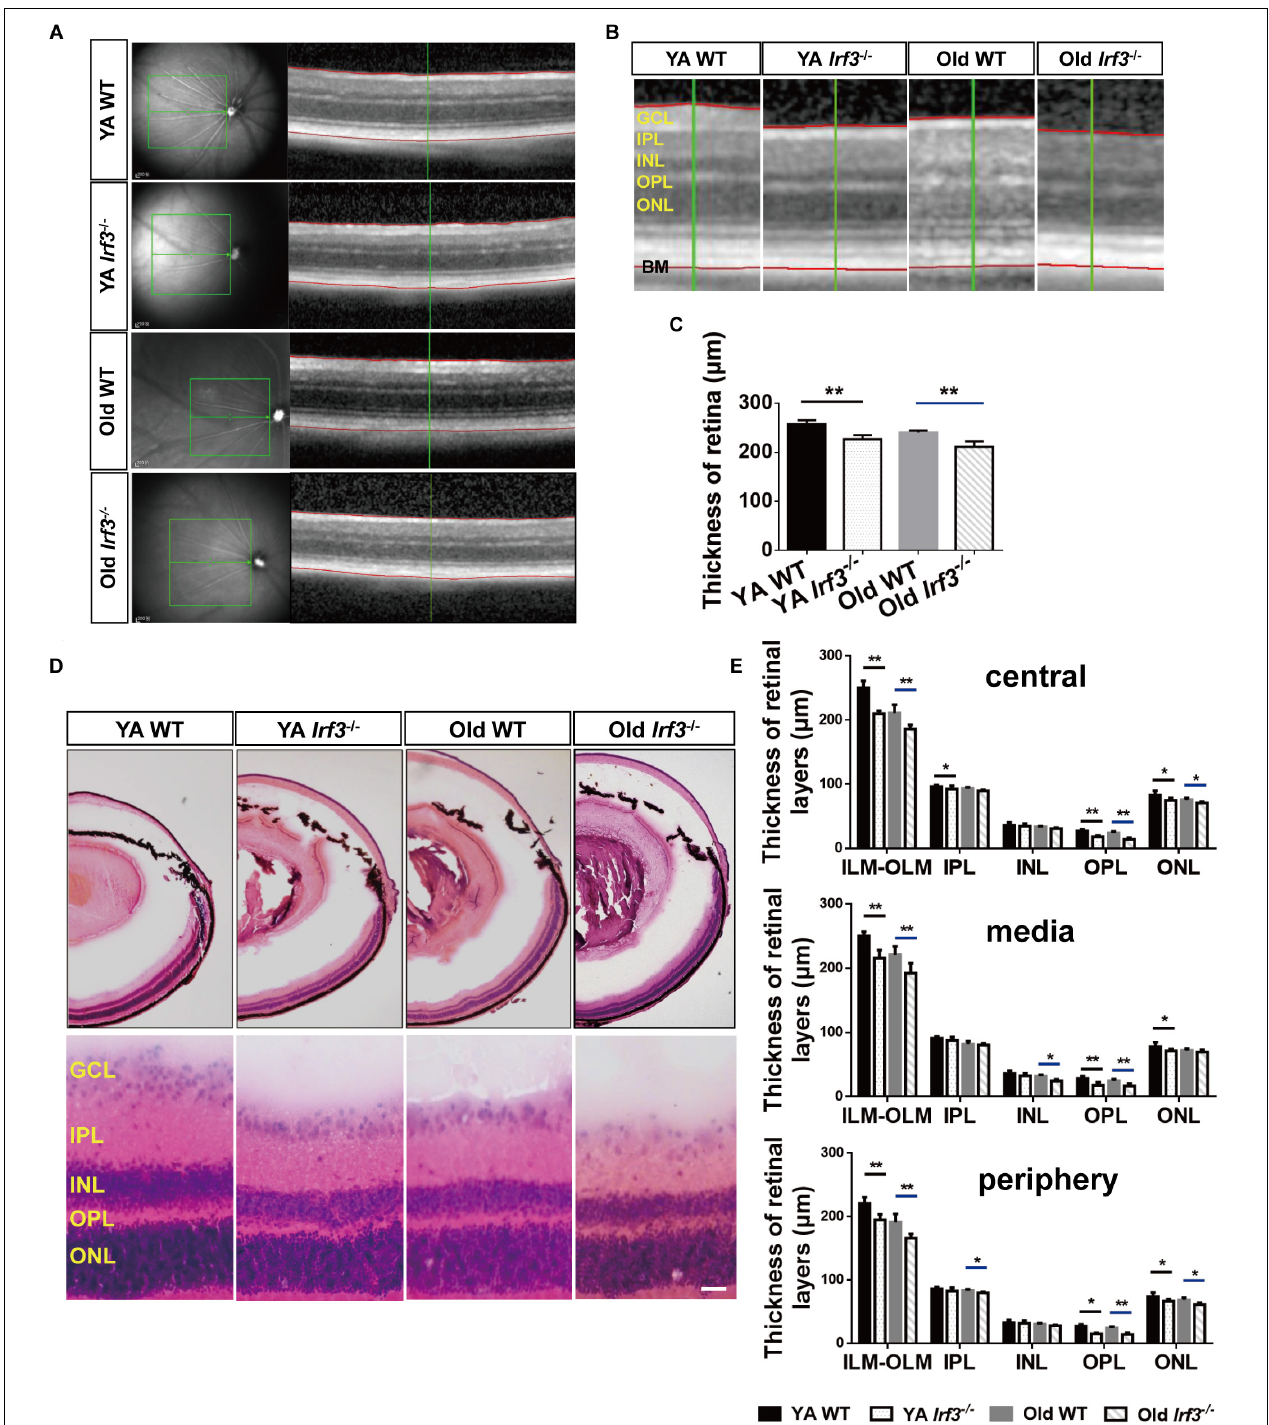
FIGURE 3 | Deletion of IRF3 interferes with retinal thickness. (A) Representative images of OCT scanning in both YA and old WT and Irf3 − / − mice. The green boxes indicate the examination area, which ranged from 250 (center) to 500 (periphery) µ m from the optic nerve. The red lines indicate the edges of the inner limiting membrane (ILM) and basal membrane (BM), respectively. (B) The amplified picture in accordance with the area near the green line on the right side of (A) . ONL, outer nuclear layer; OPL, outer plexiform layer; INL, inner nuclear layer; IPL, inner plexiform layer; GCL, ganglion cell layer. (C) Quantification of the thickness of entire retina, from internal limiting membrane to BM, for each group, Bars represent the mean ± SEM ( ∗∗ P < 0.01, n = 6 per group). (D) Representative graphs of HE retinal staining in YA WT, Old WT, YA Irf3 − / − , and Old Irf3 − / − mice. The enlarged images were arranged in the second row. Scale bars = 30 µ m (E) The quantification of thickness of designated retinal layers in three regions of the retina (central, media, periphery), including total thickness (from the internal limiting membrane (ILM) to the outer limiting membrane (OLM)), IPL, INL, OPL and ONL for each group ( n = 6 per group). Data are given as mean ± SEM ( ∗ P < 0.05, ∗∗ p < 0.01).